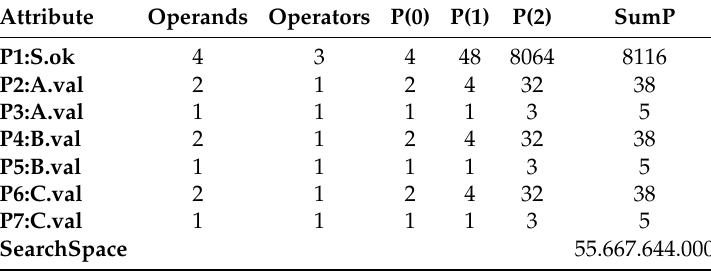
Table 1. Search space calculation for a n b n c n language when maxDepth =